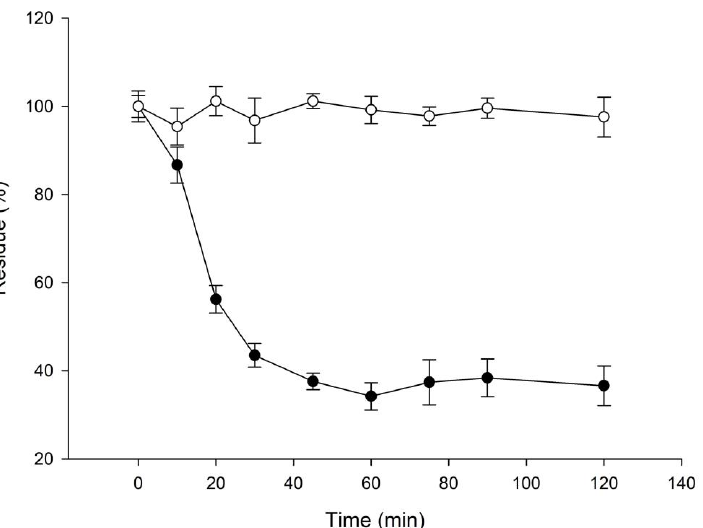
Figure 4. Stability of glycitin (open circle) and 3′-hydroxyglycitin (closed circle). The stability was analyzed by a HPLC method described in the Materials and Methods. The mean ( n = 3) is shown, and the standard deviations are represented by error bars.